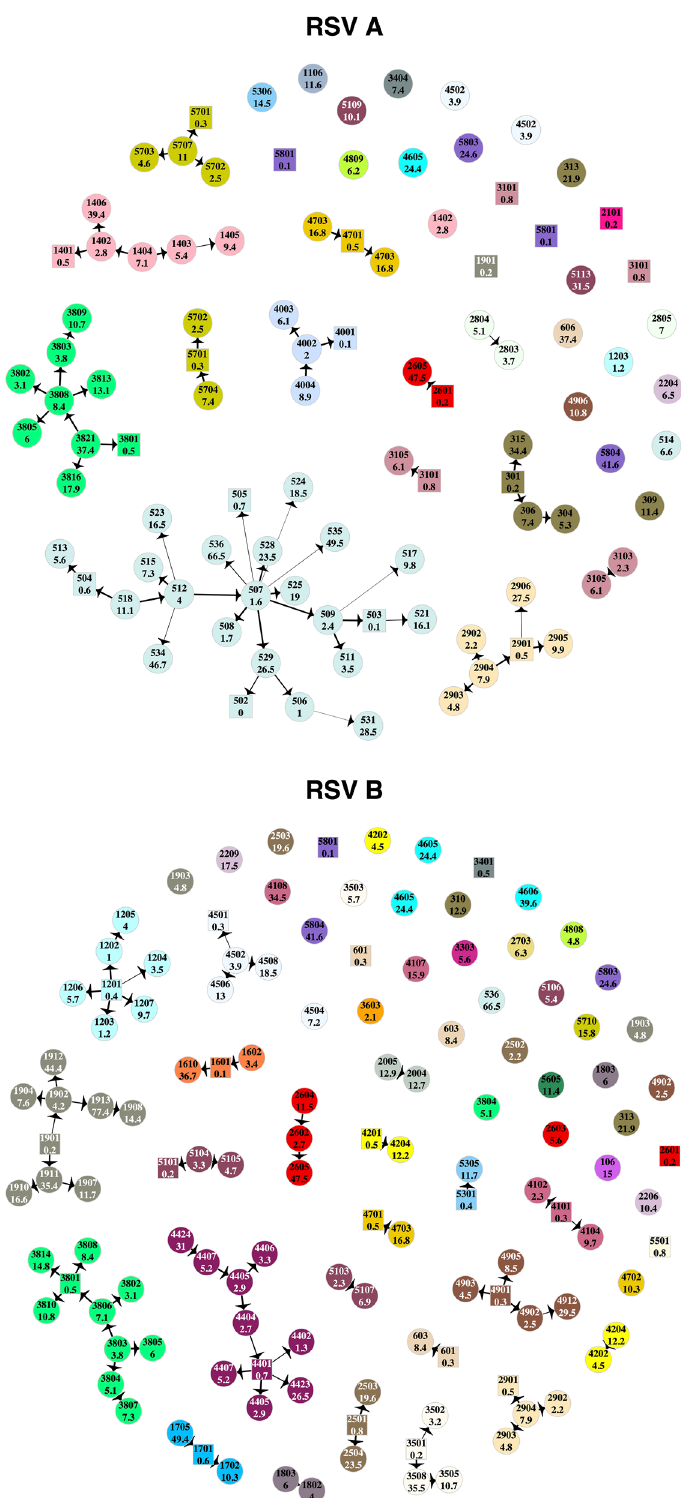
Figure 3. Transmission networks showing the highest probability source of transmission given by our model results. Each vertex is an RSV case labelled by individual study number (top) and age in years (bottom) and color-coded by household. Cases that are < 1-year-old are represented by square shaped vertices. The width of the connecting edge is proportional to the frequency at which the particular source was identified as the HPTS given different parameter set values. This figure was generated using